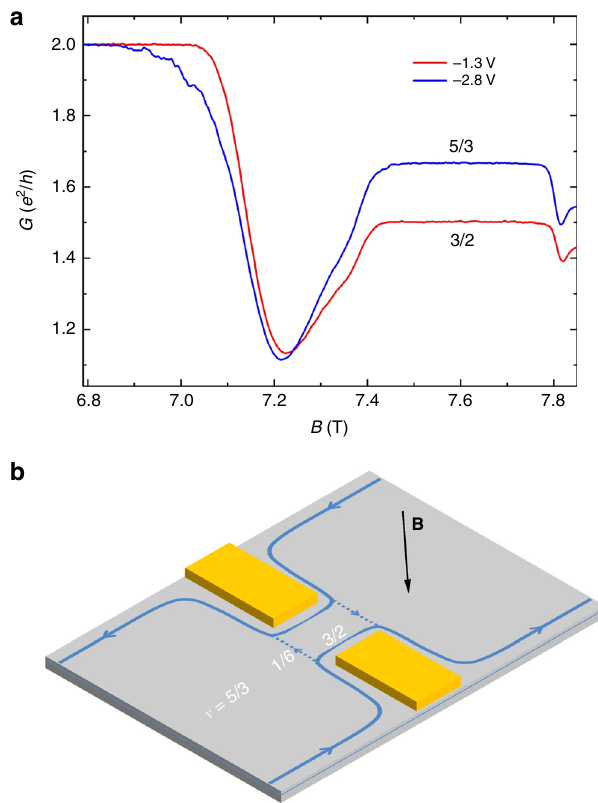
Fig. 4 Gate voltage dependence of the two-terminal conductance and the sketch of the propagating edge channels. a Two-terminal conductance traces at 18 mK with V gate = − 1.3 V and V gate = − 2.8 V respectively. The measurement was carried out by applying a voltage excitation to the contact S and measuring the current from contact D (contacts S and D are the same con fi gurations as that shown in Fig. 1a). b The sketch of the propagating edge channels for the formation of the 3/2 FQH plateau. In the bulk, the fi lling factor is 5/3. In the con fi ned region, the straight lines represent the transmitting conductance quantized at 3 lines represent the tunneling conductance quantized at 1 provided as a Source Data fi factor 3/2 or at a smaller fi lling factor, which is contradicted to the experimental observation ( − 2.8 V at Fig. 3a). This argument serves as an additional clue that the 3/2 FQH plateau appears at the fi lling factor of 5/3. The 3/2 FQH plateau has also been observed in Charles M. Marcus group, shown in Yiming Zhang ’ s thesis 27 . In with both uniform density and non-uniform density. From the